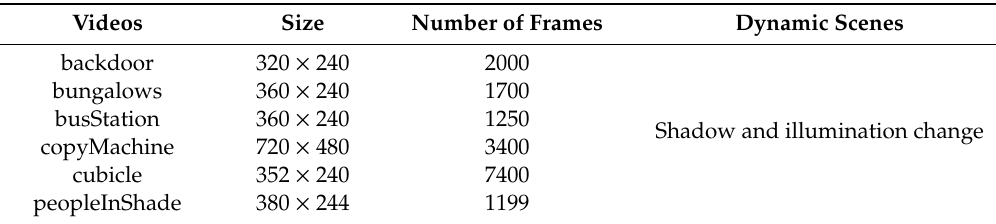
Table 6. Shadow videos.